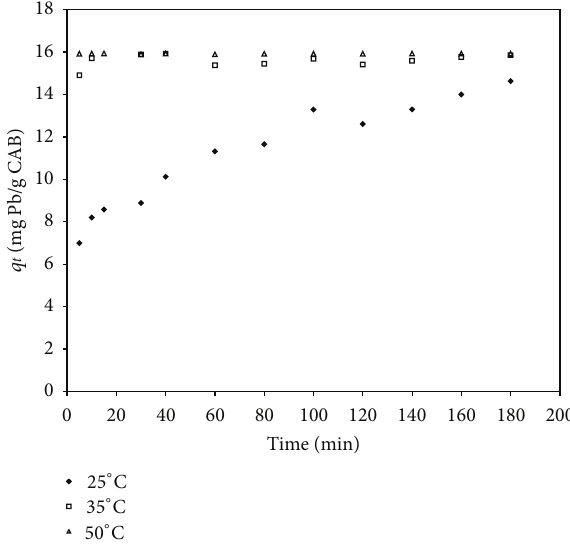
Figure 2: Adsorption capacity ( 𝑞 𝑡 ) of lead by CAB at different temperatures ( ∘ C) versus time